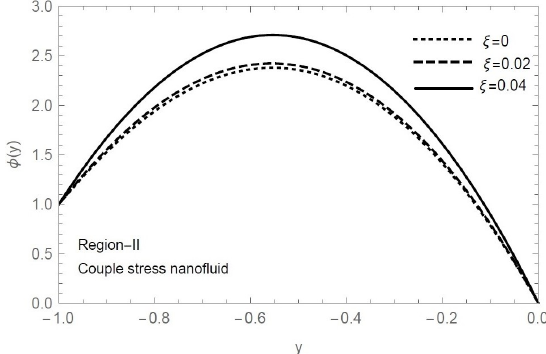
Figure 5: The influence of Brownian motion parameter N b on mass transfer keeping λ 1 = 50, Pr i = 5, h = 1, ξ i = δ i = 0.1, Γ i = 1, N t = 0.01 and µ = K = 0.5 .